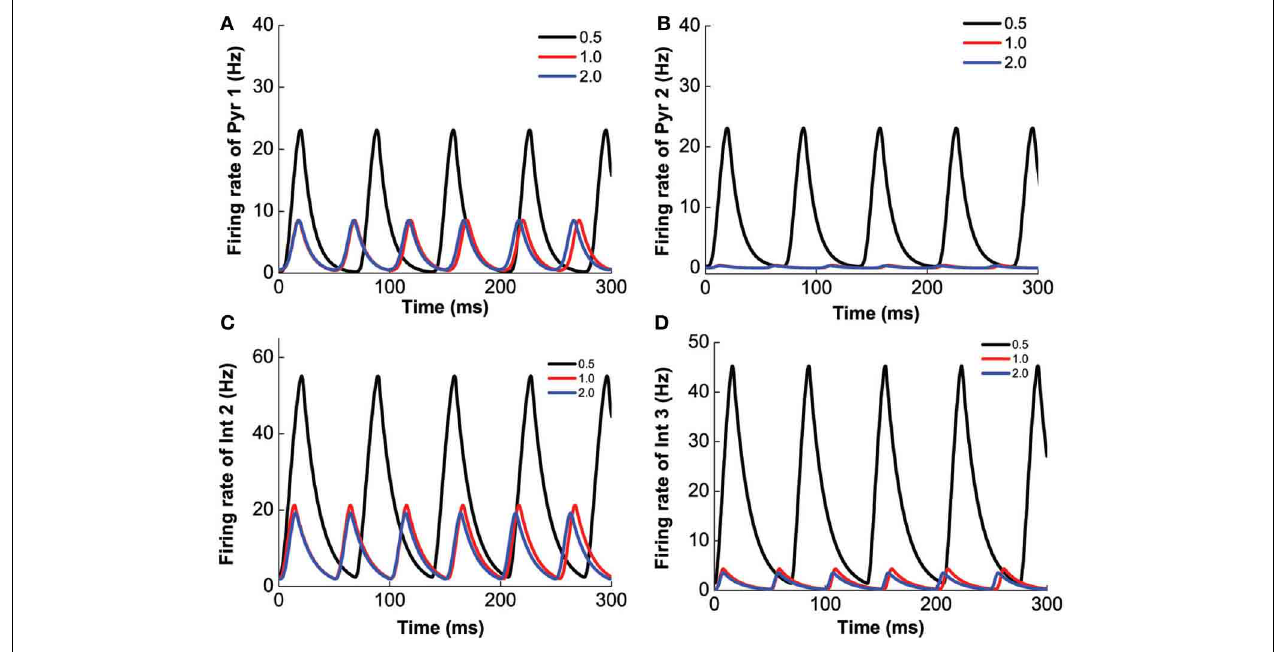
FIGURE 13 | 5-HT2A selective agonist/antagonist on the network behavior. Increasing [5- HT ] 2 from 0 . 5 to 2 . 0nM, the amplitude of the firing rate oscillation decreases, but the frequency of the oscillation slightly